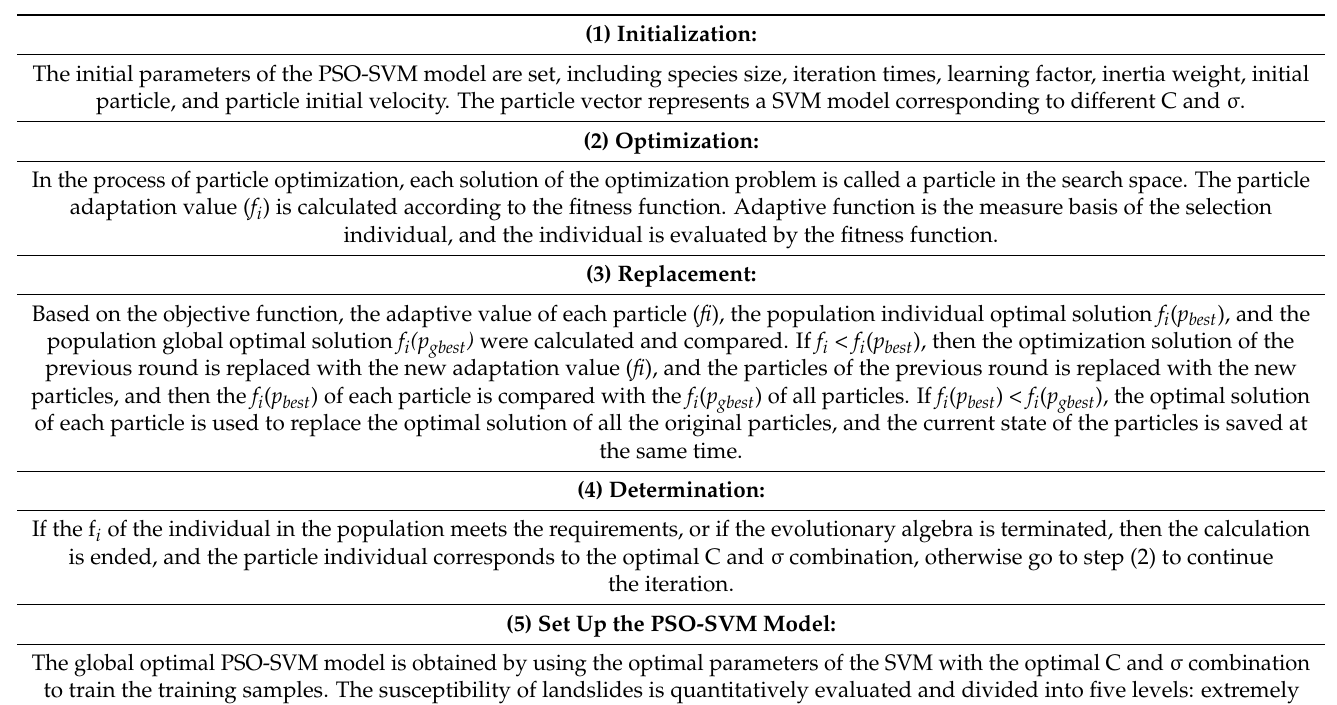
Table 2. The main steps of the particle swarm optimization support vector machine (PSO-SVM)